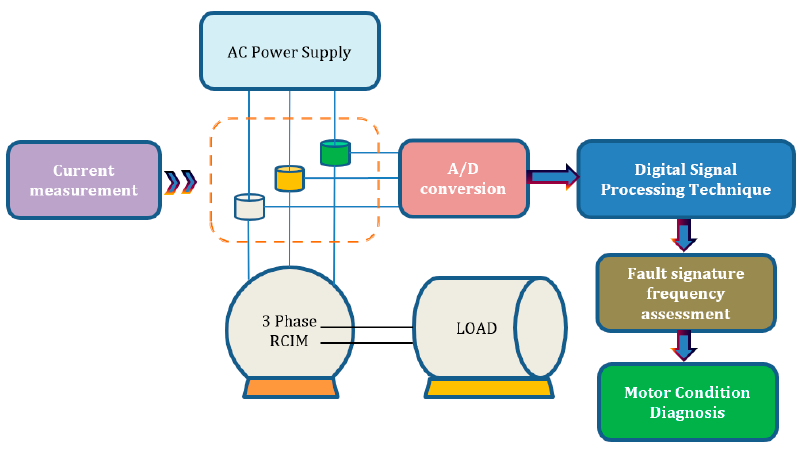
Figure 2. General scheme of MCSA for RCIM.